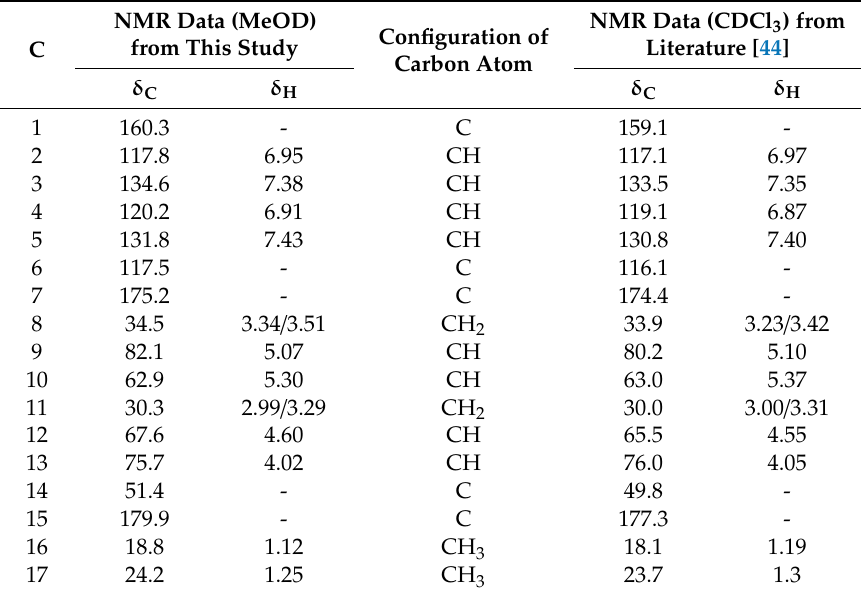
Table 2. 1 H and 13 C NMR signals of the isolated ulbactin B in MeOD, which are in good agreement with data reported in the literature [31]. NMR Data (MeOD) NMR Data (CDCl 3 ) Configuration of from This Study C Carbon Atom